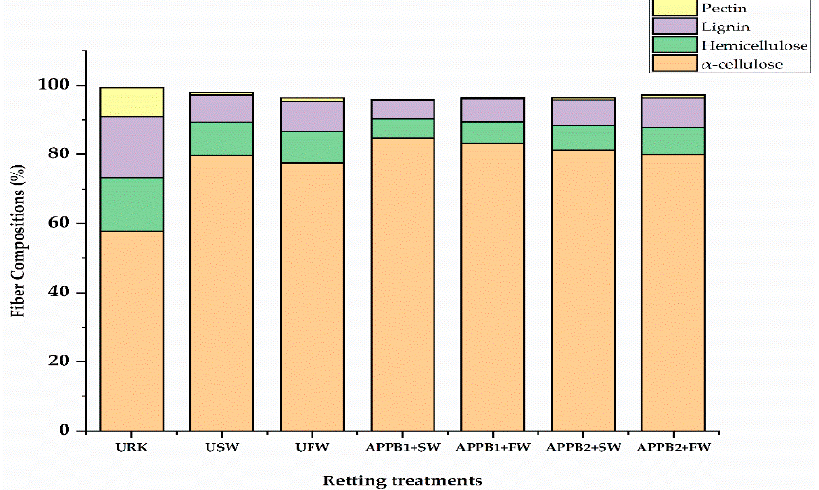
Figure 6. Compositions of the kenaf bast fibers retrieved from augmented retting in comparison with unretted raw kenaf.